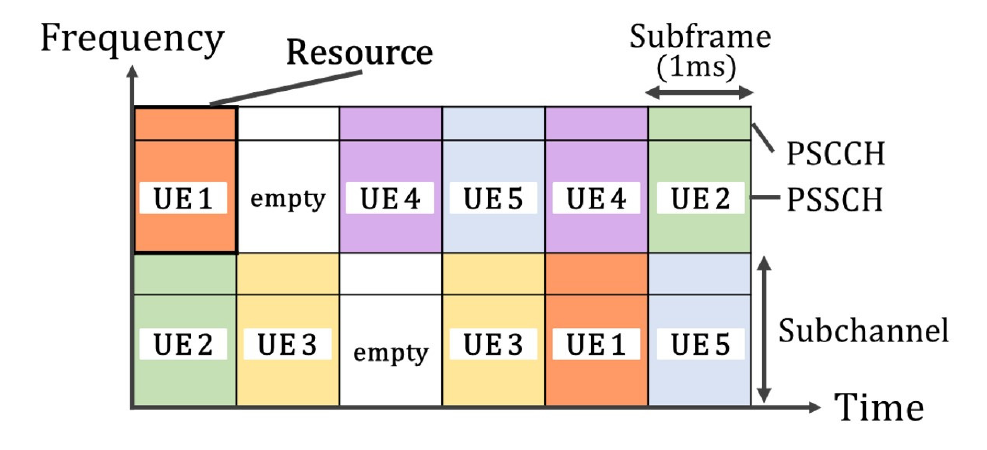
Figure 2. An example of resource usage for the sidelink